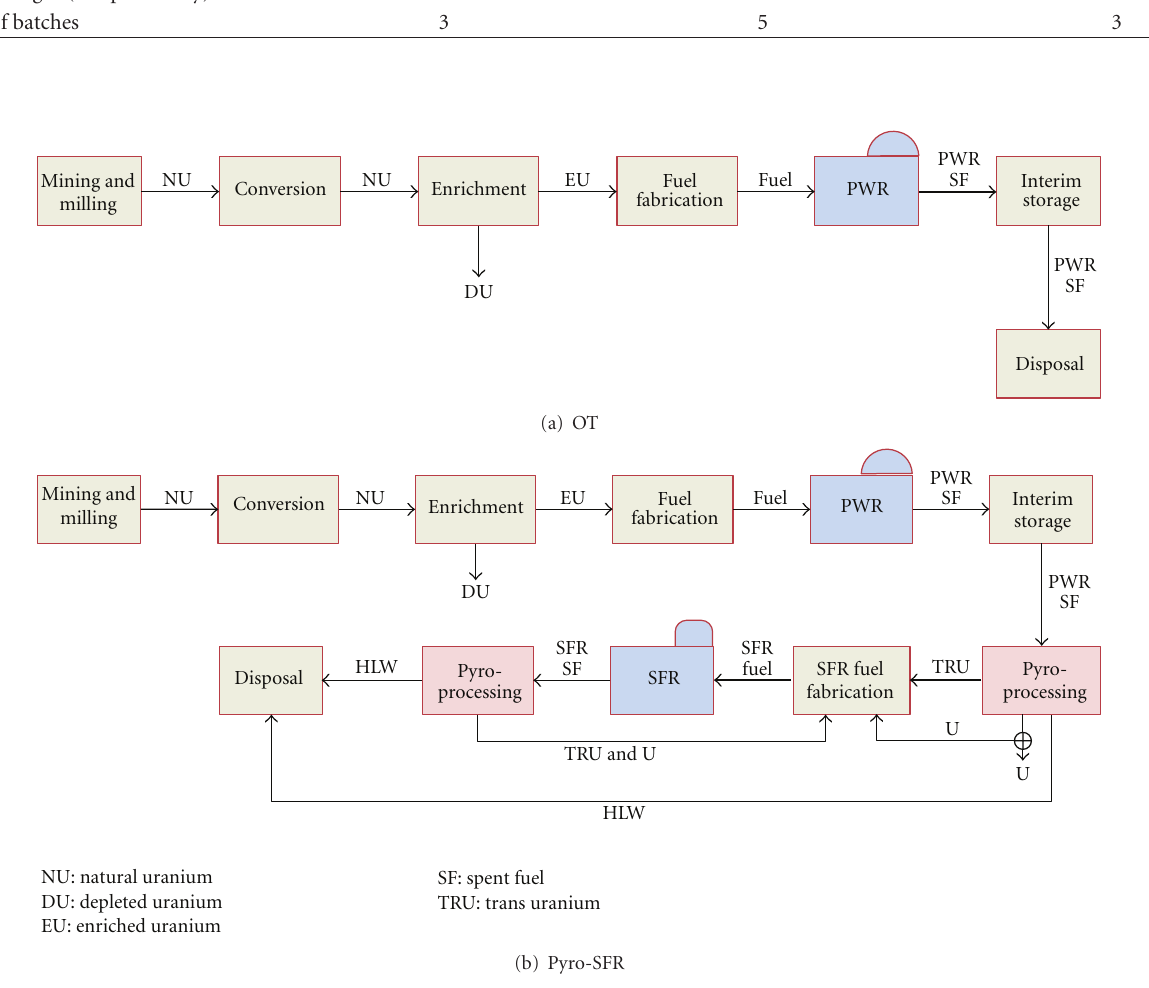
Figure 1: Schematic description of Pyro-SFR fuel cycle option. ∗ NU: natural uranium; DU: depleted uranium; EU: enriched uranium; SF: spent fuel; TRU: trans uranium.